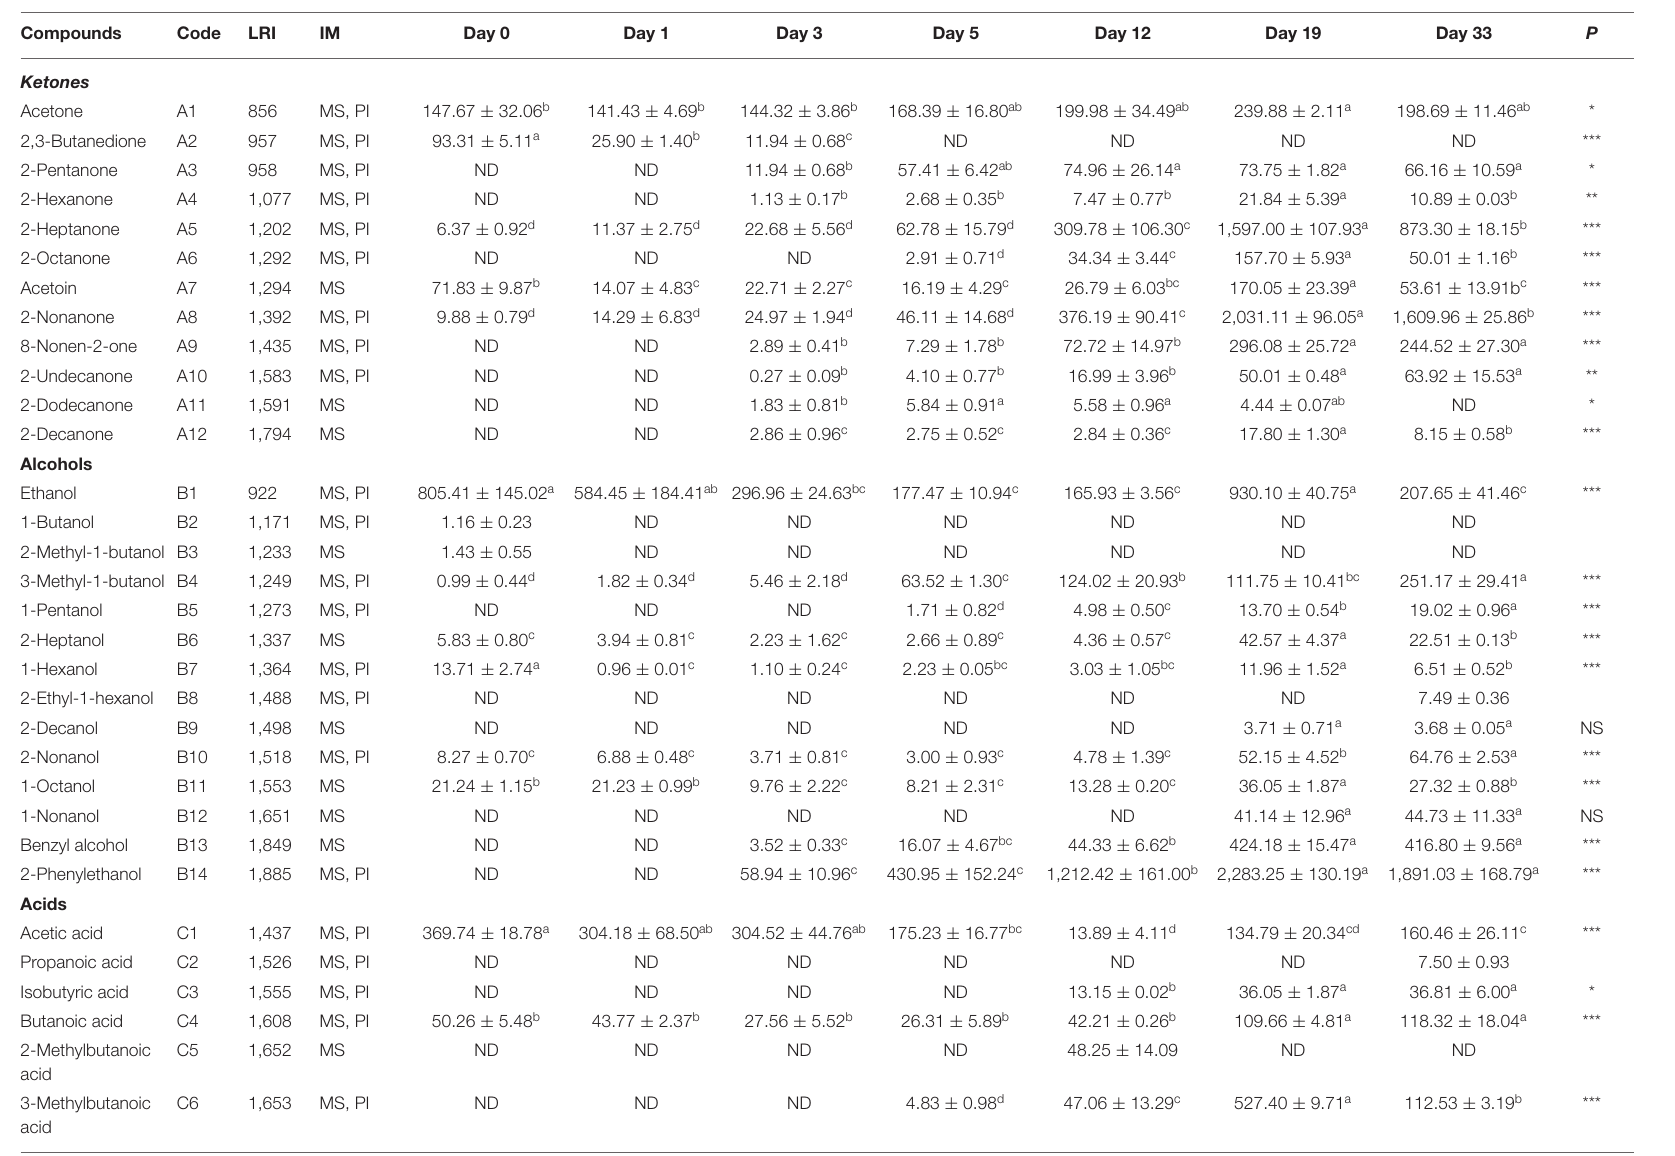
TABLE 4 | Volatile compounds identified in Red-Veined Cheese by HS-SPME-GC-MS during the different ripening stages.